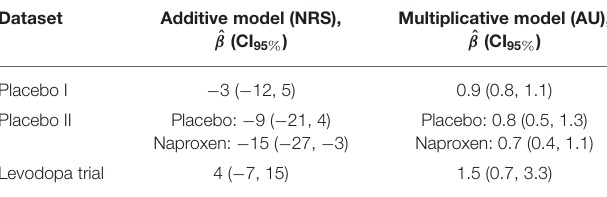
TABLE 1 | Additive and multiplicative effects by dataset.